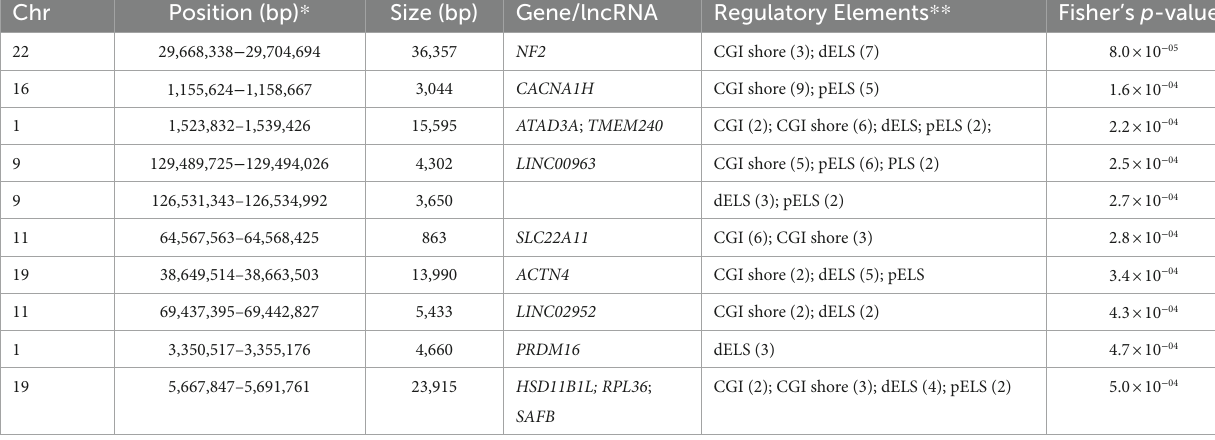
TABLE 2 Top-10 differential hydroxymethylation regions (DhMRs) between iPSC and NSC cell lines.